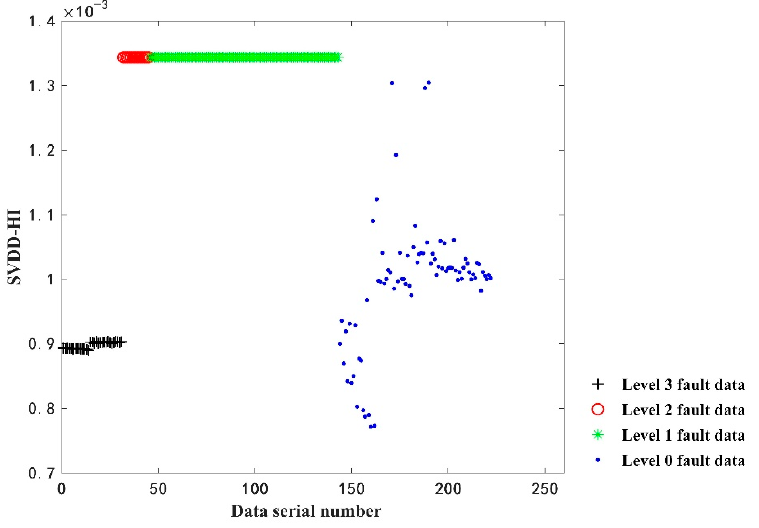
Figure 13. The results of SVDD-HI fusion.